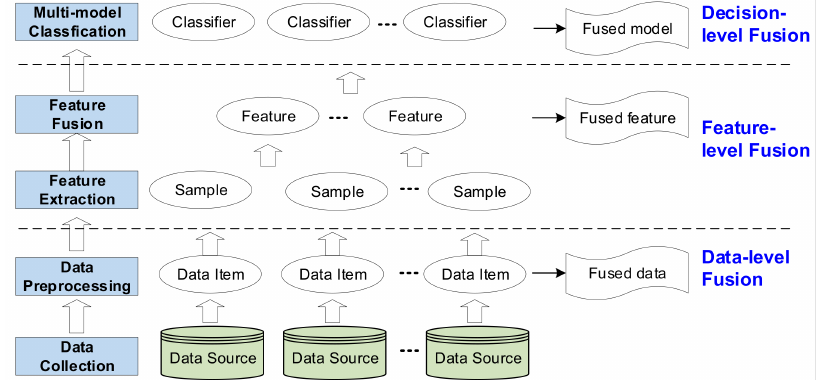
Figure 3. The fusion process, including three levels.